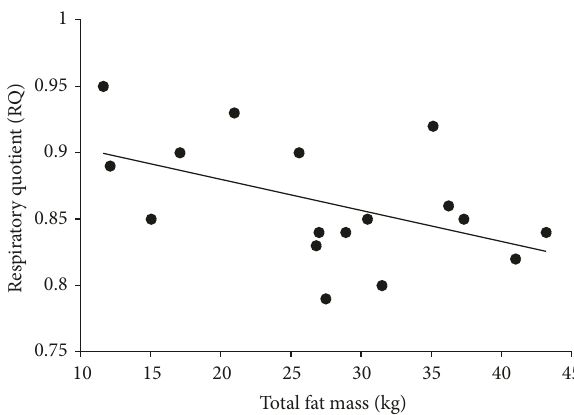
Figure 1: Fasting RQ was negatively associated with total fat mass ( 𝑟 = −0.496 , 𝑝 = 0.043